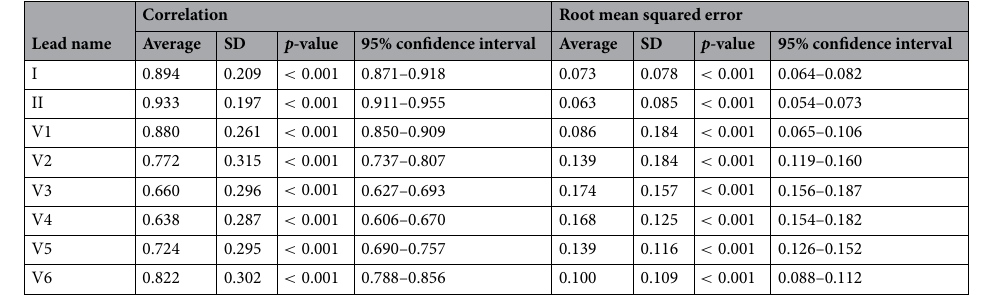
Table 3. Correlation and root mean squared error (RMSE) statistics of the digitised results from selected 308 12 by 1 ECG images and the ground truth digital ECGs before image thresholding (validation